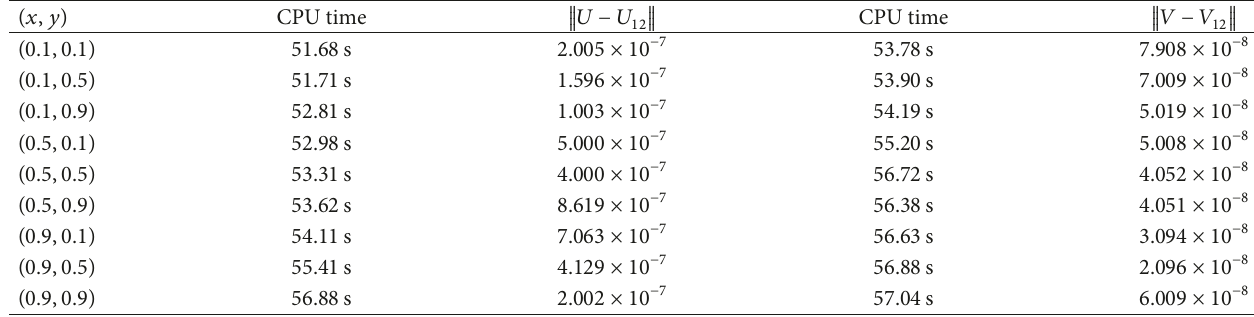
Table 4: Absolute error and CPU times at various values of (𝑥,𝑦) for 𝐾 = 12 in 𝑈(𝑥, 𝑦) and 𝑉(𝑥, 𝑦) of Problem